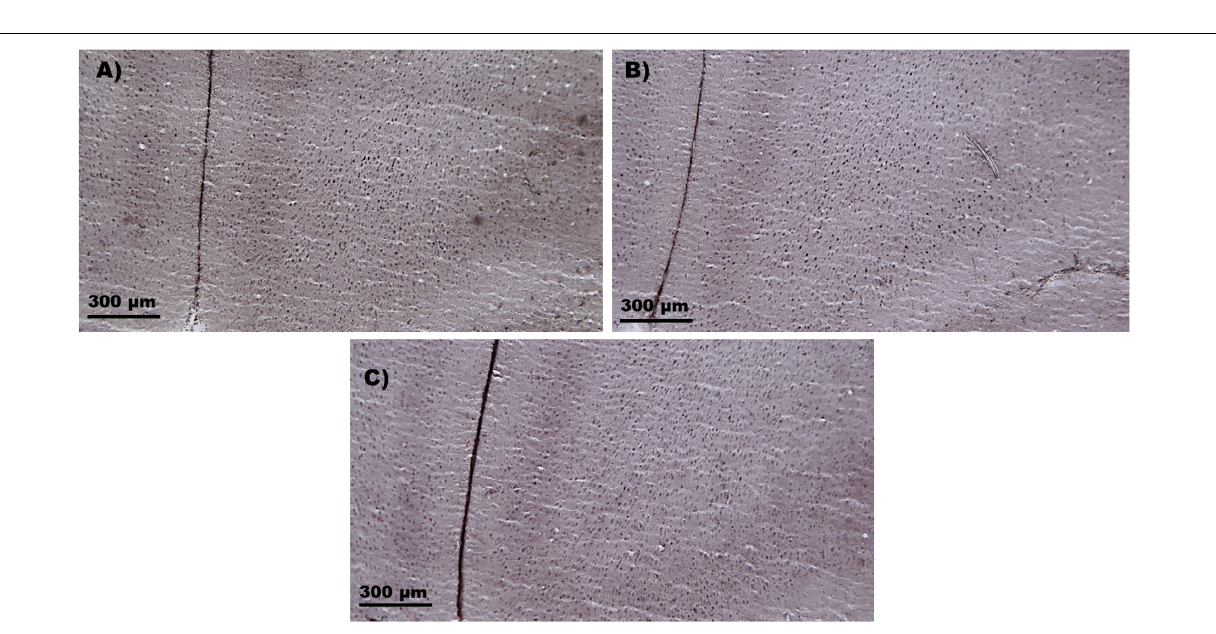
FIGURE 5 | c-Fos samples. Representative microphotograph of the c-Fos immunostaining in the IL cortex. (A) c-Fos sample of the control group. (B) c-Fos sample of the photobiomodulation device group. (C) c-Fos sample of the photobiomodulation group. No differences in c-Fos protein expression were found between the three groups in the male or female groups. IL, Infralimbic